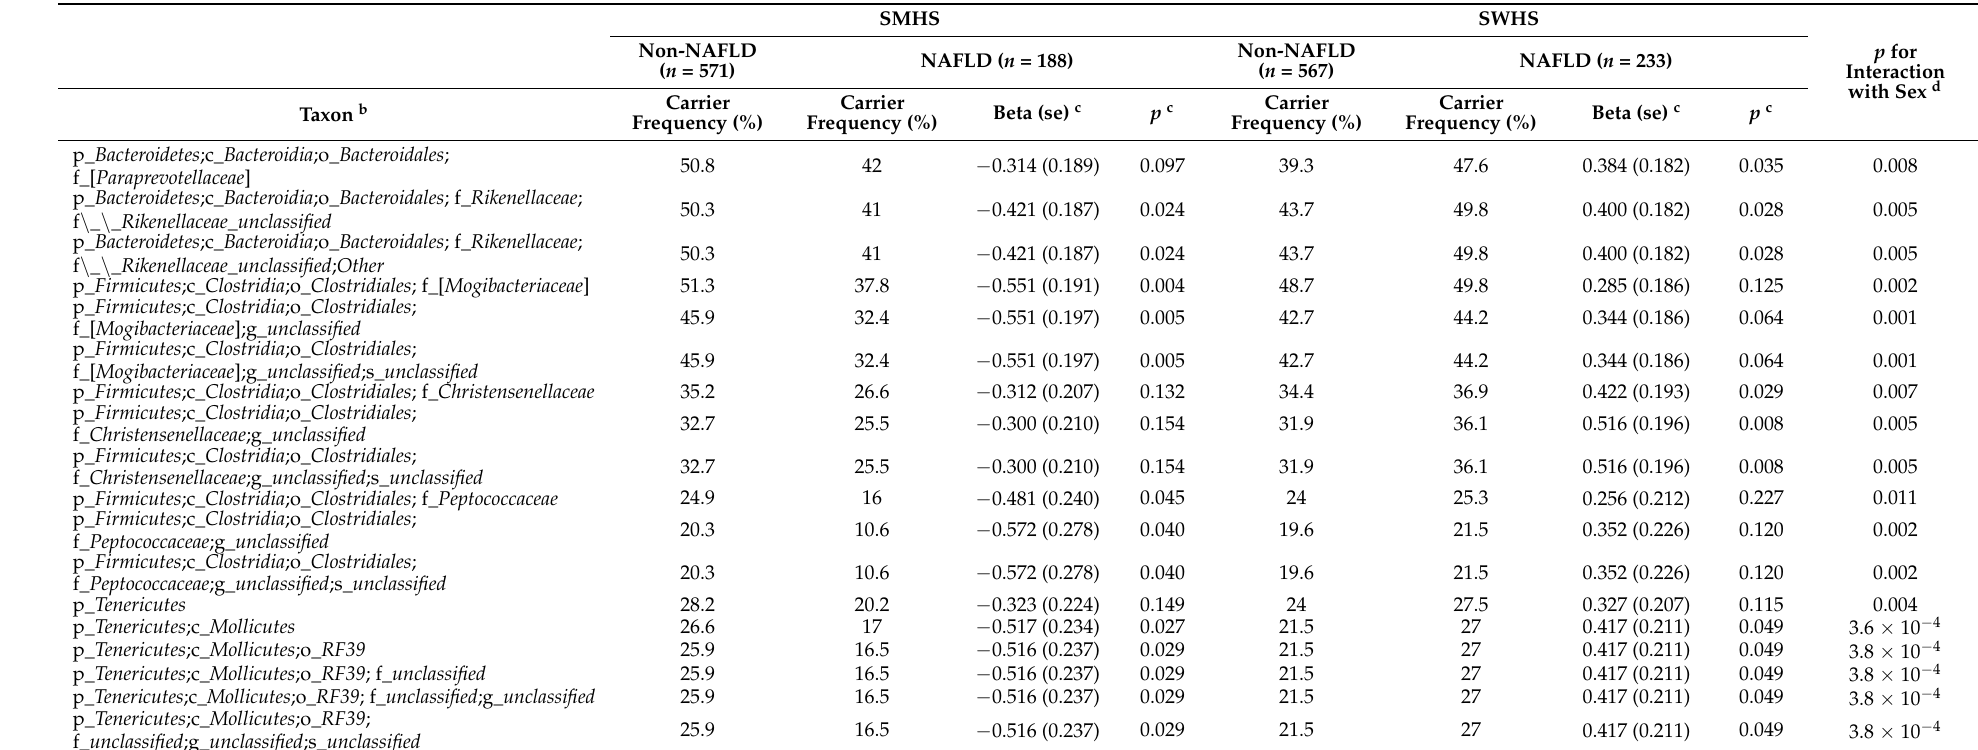
Table 3. Sex-dependent associations of non-alcoholic fatty liver disease and rare bacterial taxa a